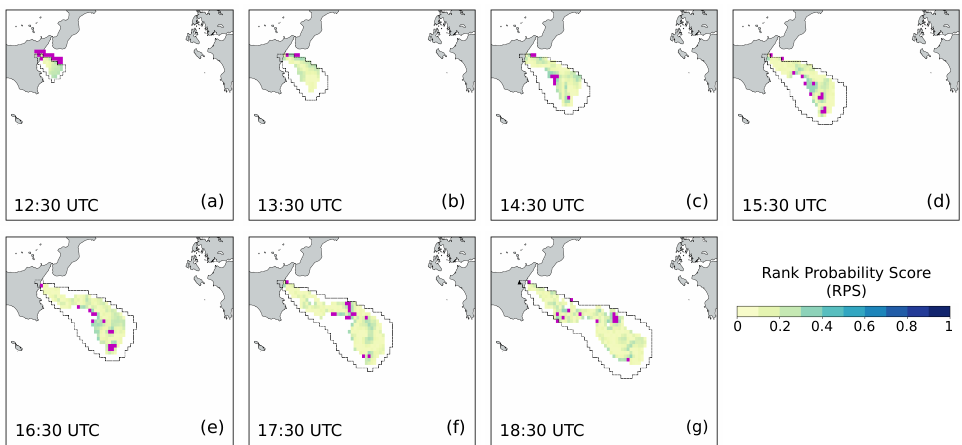
Figure 10. Panels from ( a – g ) show the Rank Probability Score ( RPS ) computed for the different time slices: 12:30, 13:30, 14:30, 15:30, 16:30, 17:30 and 18:30. RPS was evaluated for the pixels presenting an observed value different from zero. The magenta pixels indicate the observations falling outside the range of the m ensemble values computed for the specific pixel. Dotted lines show the numerically predicted ash cloud.